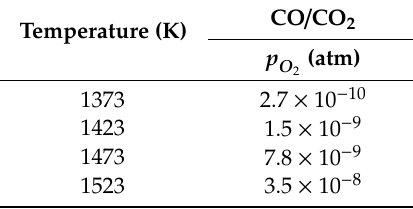
Table 4. Oxygen partial pressures to which the pellets from Blend 2 were exposed during